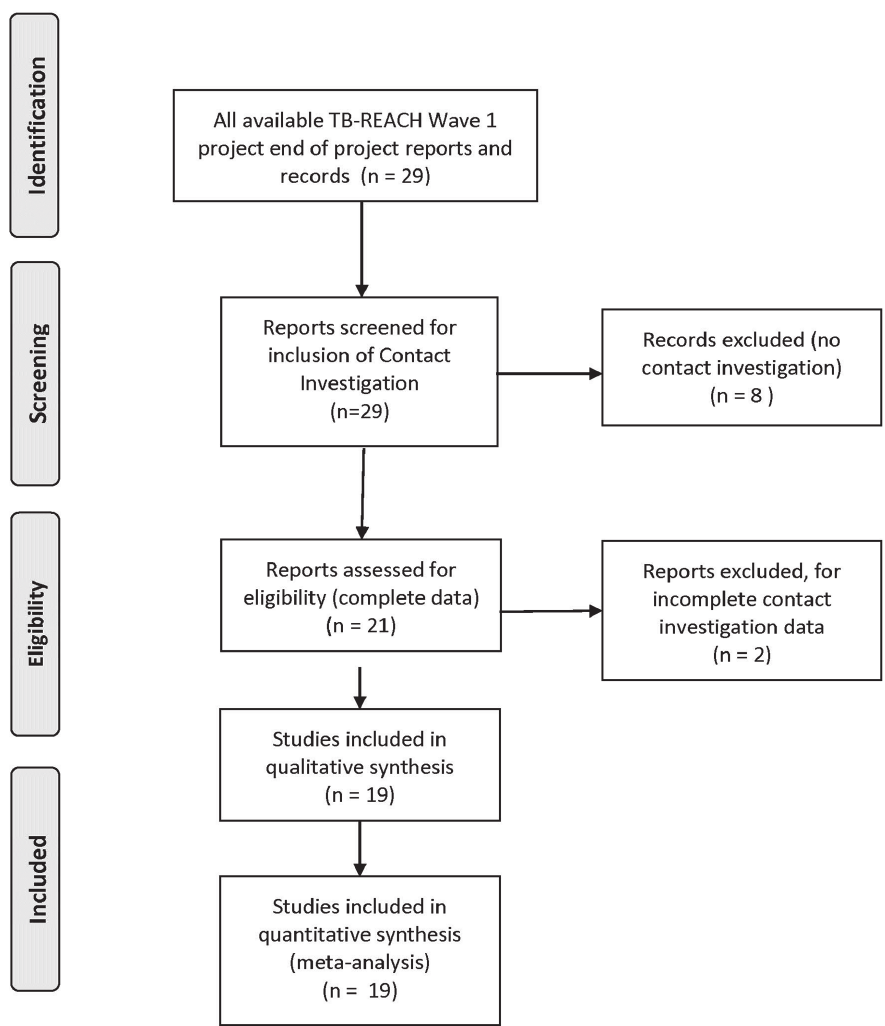
Fig 2. Screening for Study Inclusion